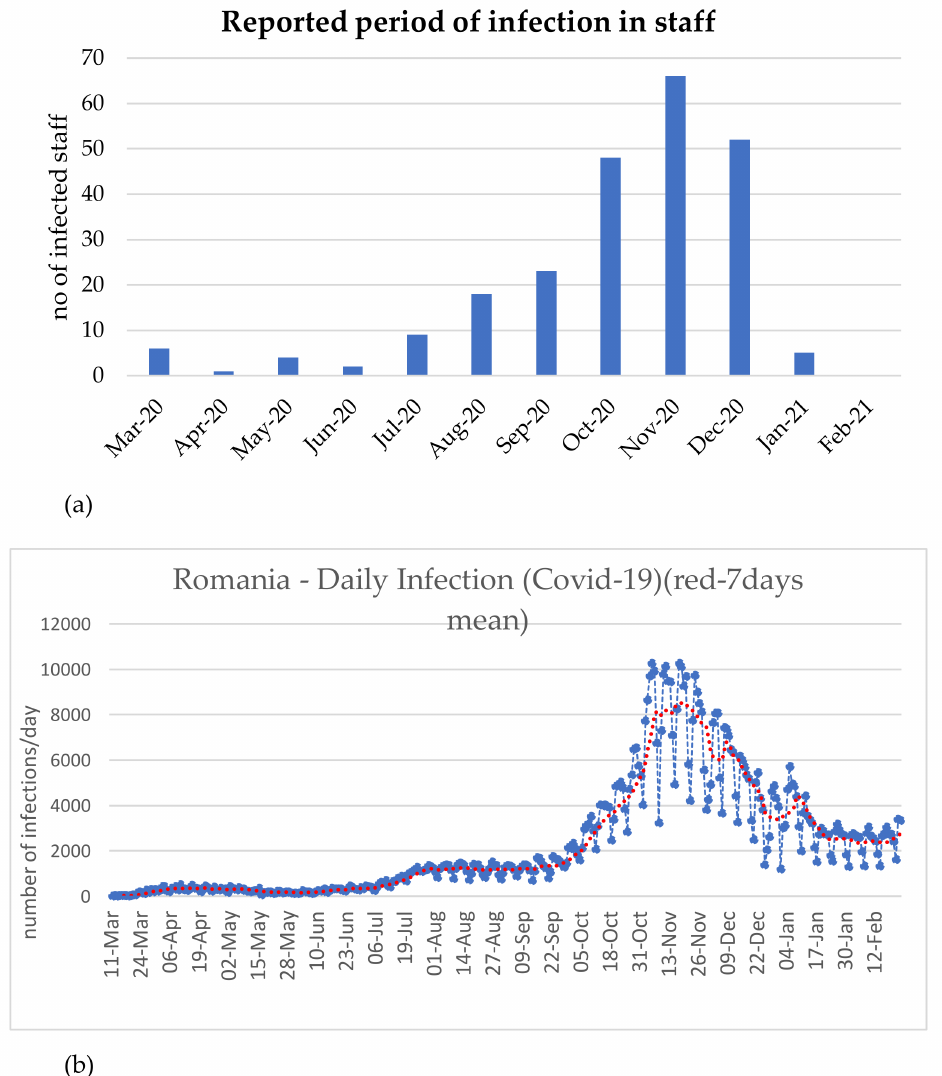
Figure 4. ( a ) Contamination rate among dental practitioners in the dental office. ( b ) General Roma- nian population infection